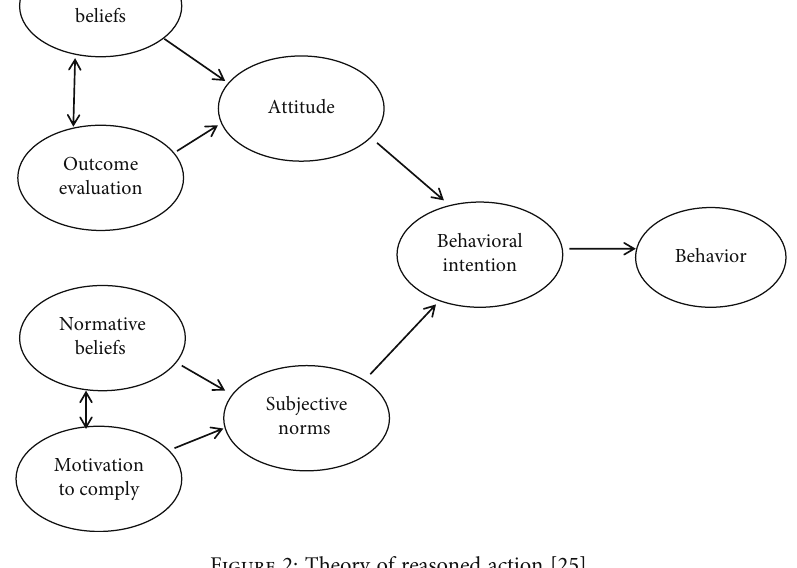
Figure 2: Theory of reasoned action [25].